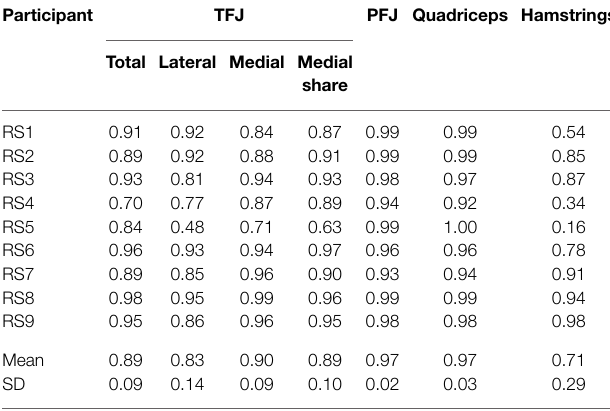
TABLE3 | Within-subjectagreement(correlationcoefficients)betweentestsessions TABLE4 | Within-subjectagreement(correlationcoefficients)betweentestsessions 1 and 2 for the mean waveforms of trials 1 to 3 for gait. 1 and 2 for the mean waveforms of trials 1 to 3 for stair ascent. Participant TFJ PFJ Quadriceps Participant TFJ PFJ Quadriceps Hamstrings Total Lateral Medial Medial share